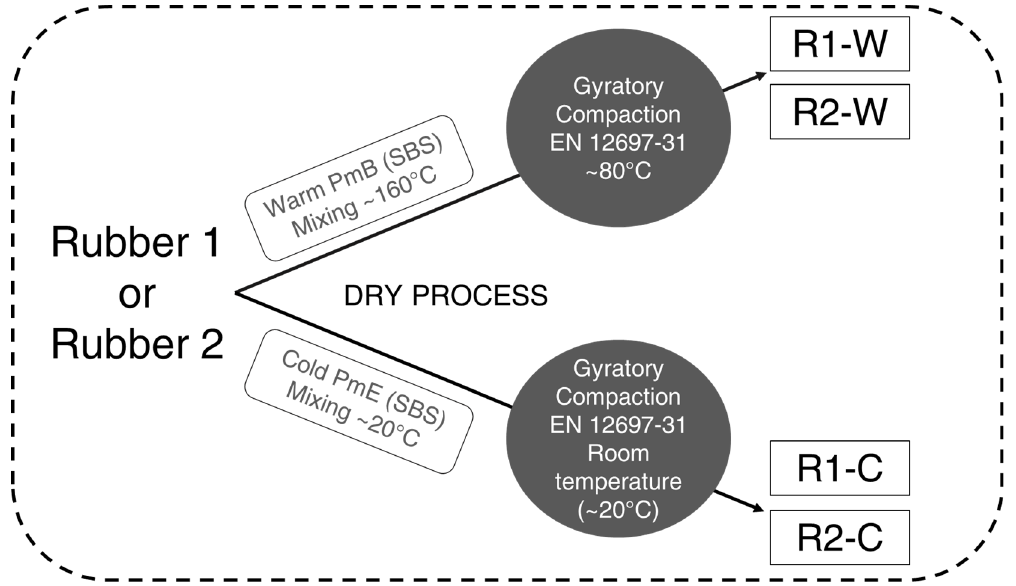
Figure 1. Rubberised asphalt production